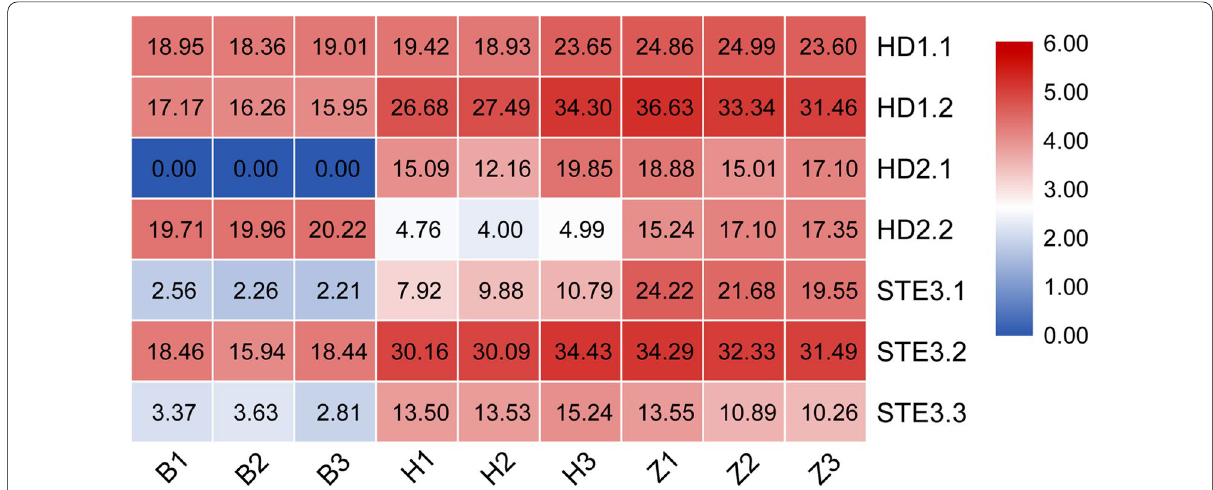
Fig. 7 The expression of HD and PR mating-type genes in H. marmoreus strains Hm88-W2, Hm61-G6 and HMZ5. B indicates the monokaryotic strain Hm88-W2, H indicates the monokaryotic strain Hm61-G6, Zrepresents HMZ5, the hybrid strain of Hm88-W2 and Hm61-G6 and repeats three times. HD : homeodomain (HD) genes; PR : the pheromone receptor